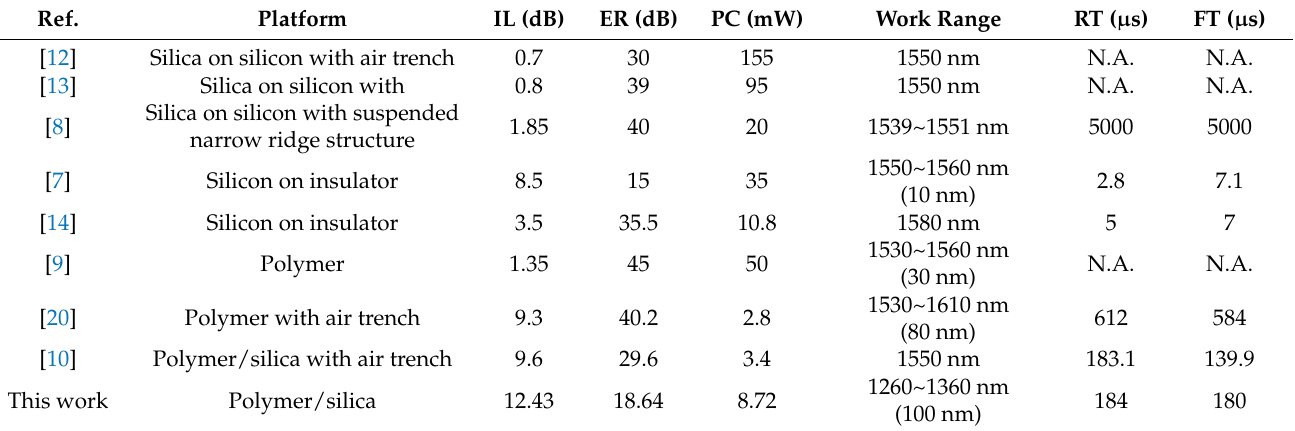
Table 1. Comparison of the